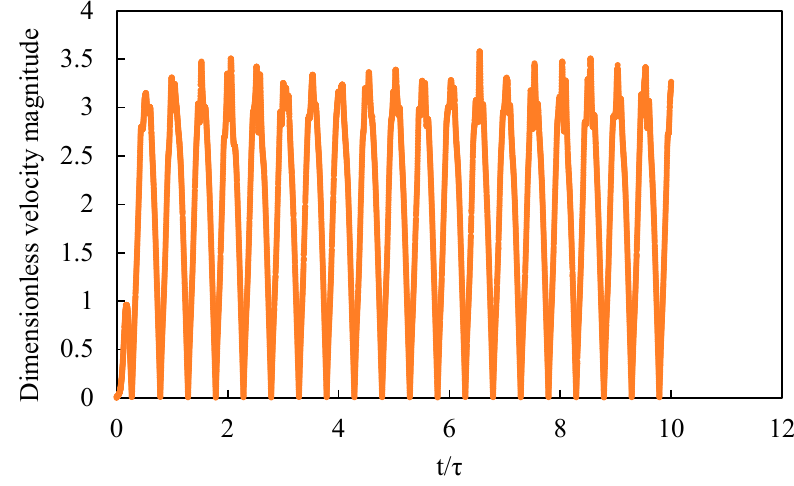
Figure 2. Dimensionless velocity magnitude ( V /2 π fx o ) of the flow at the center point of the reactor over the time (t / τ ) (oscillation frequency = 2 Hz and oscillation amplitude = 40 mm). To ensure our model could realistically mimic the actual reactor, droplet size distributions (DSD) were obtained by averaging DSD data over an oscillation period considering 2 Hz of oscillation